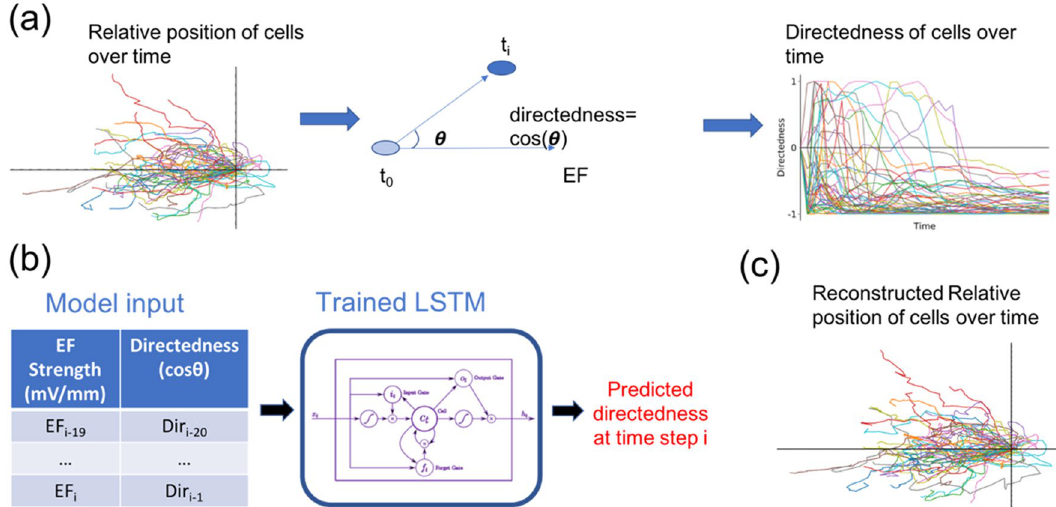
Figure 2. ( a ) Quantifying directional movement of cells by directedness. ( b ) Trained LSTM model takes in directedness and EF values from the past 20 times steps and outputs directedness at current time step. ( c ) Reconstruction of single-cell trajectories from directedness assuming constant cell